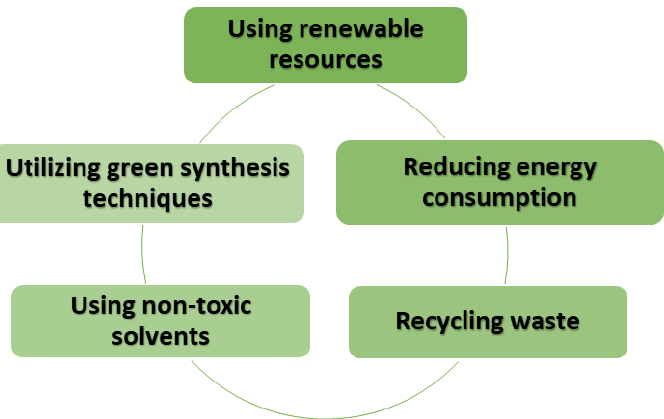
Figure 7. Eco-sustainable synthesis of TiO 2 : steps for a greener future.